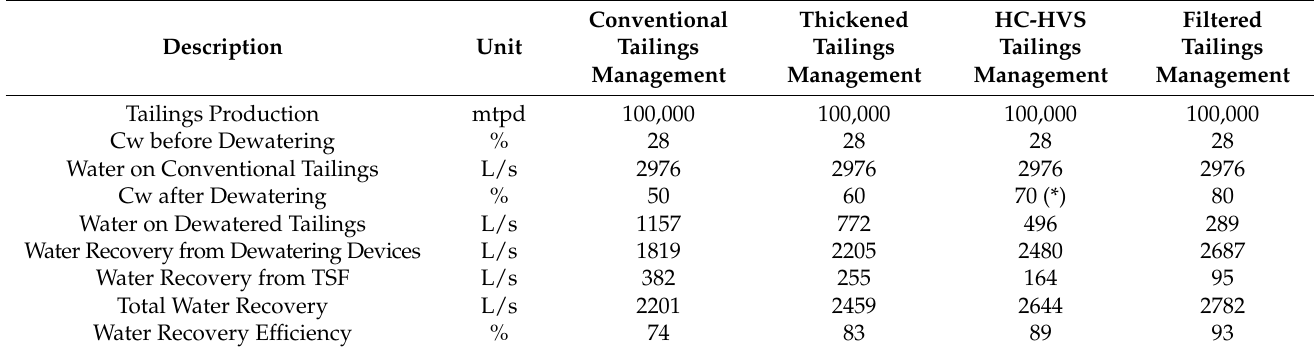
Table 4. Water Recovery Comparison between Different Mine Tailings Management